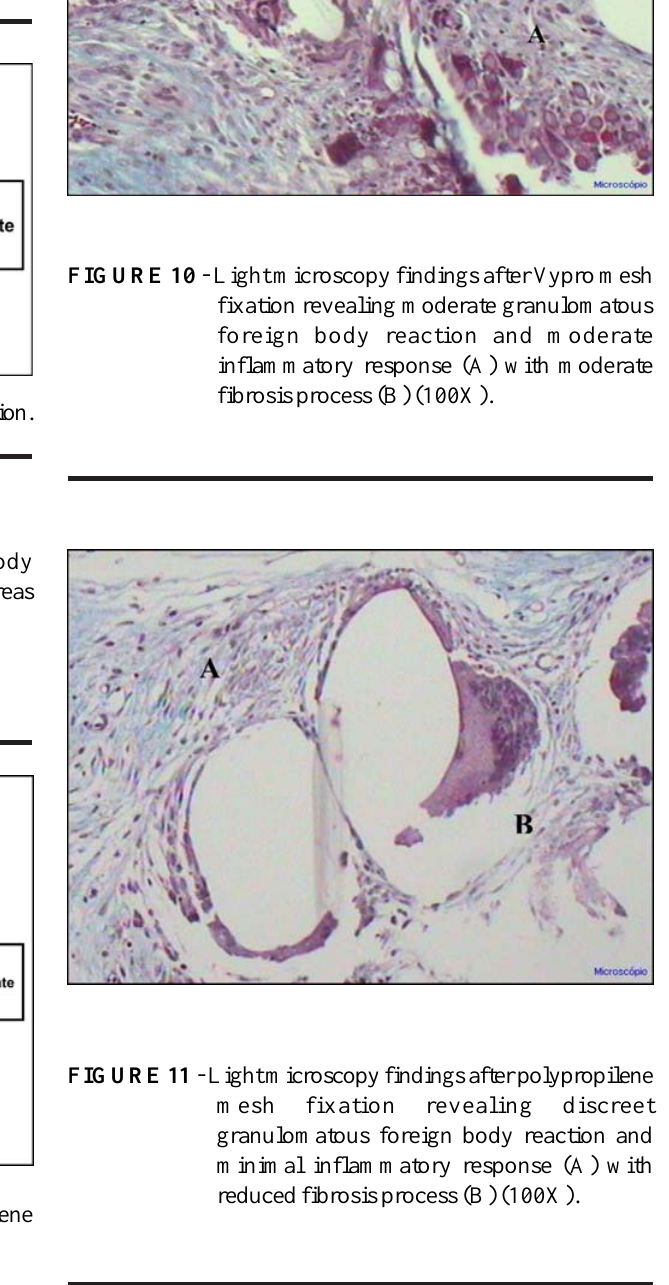
FIGURE 7 - Firm adhesions between the mesh and the bowel.